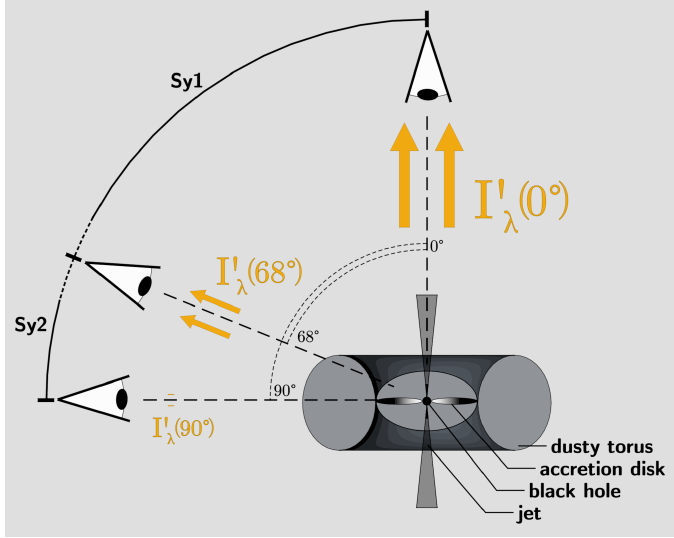
Figure A1. Visually explaining Equations (2) and (3): the unified model of AGNs proposes that the difference between Type-1 and Type-2 AGNs, in our case Seyfert (Sy) galaxies, which is nominally determined by spectral features, is due to the viewing angle relative to the AGN plane with its accretion disk. In this case, the luminosity received along a certain viewing angle also changes, with [13] proposing the equations above to calculate the luminosity as a function of luminosity along the pole-on direction, which sees the maximum area of the luminous accretion disk. They also propose 68° as the separating angle between Sy1 and Sy2 systems. As such, we deem 68° a sufficient angle for the approximate extent of the dusty torus over the equatorial plane and, as such, an adequate limit angle for potential planetary